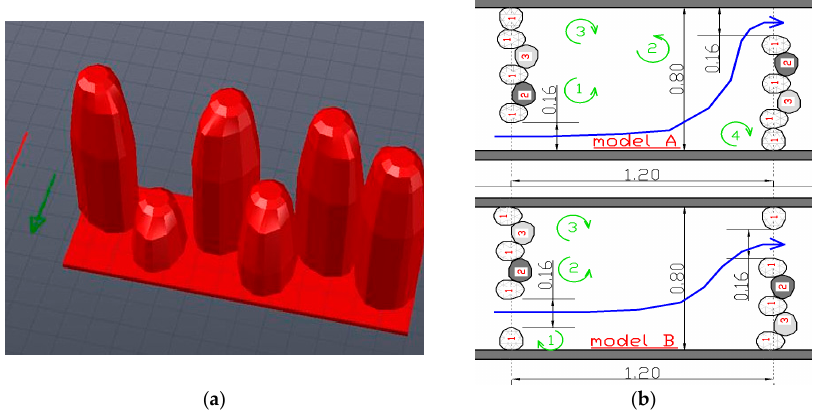
Figure 1. Construction of models: ( a ) cross-barriers of bolt elements; ( b ) (top) model A—dimensions given at the model scale (m); (bottom) model B—dimensions are at the model scale (m). Note: location and direction of rotation for huge whirl structures are marked in green.